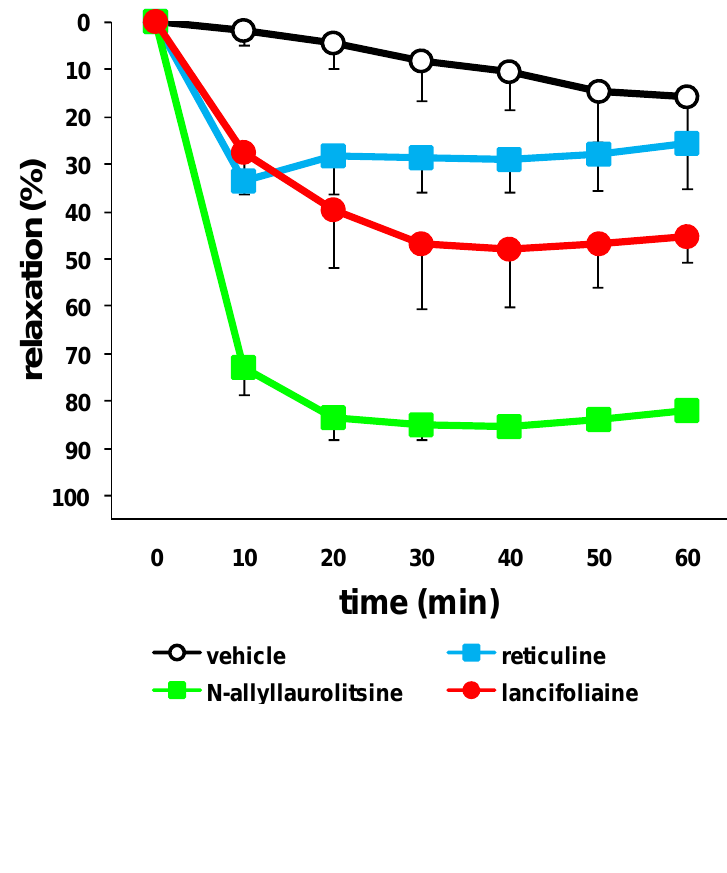
Figure 4. Relaxation responses induced by lancifoliaine ( 1 ; 10 − 4 M), N -allyllaurolitsine ( 2 ; 10 − 4 M), and reticuline ( 3 ; 10 − 4 M) in aortic rings precontracted with 3 × 10 − 7 M phenylephrine (PE). Values are the mean ± S.E. (n =